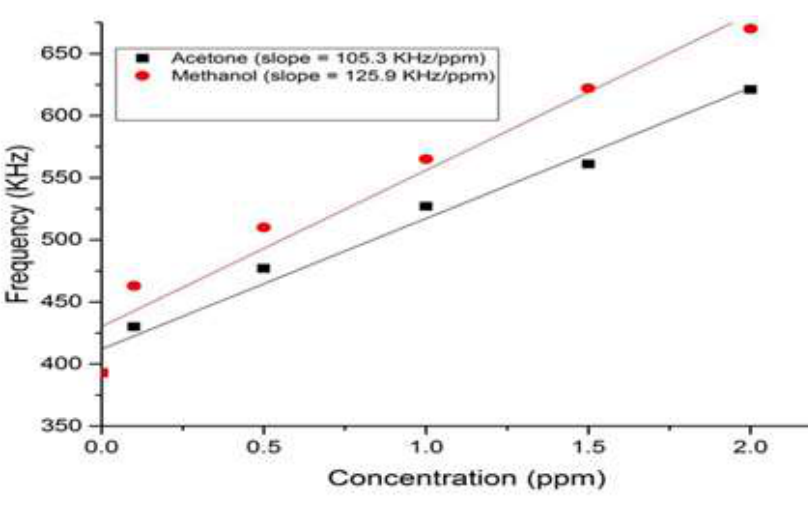
Figure 10: Resonant frequency (f) dependence on Chlorpyrifos concentrations (0.1ppm to 2ppm) for the S 3 sensor.